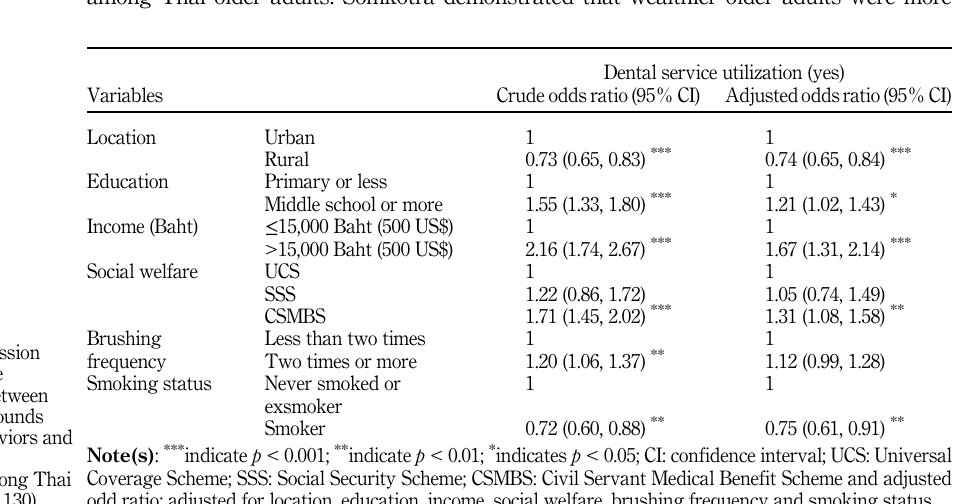
Table 2. Logistic regression models for the association between social backgrounds and oral behaviors and dental service utilization among Thai elderly ( n 5